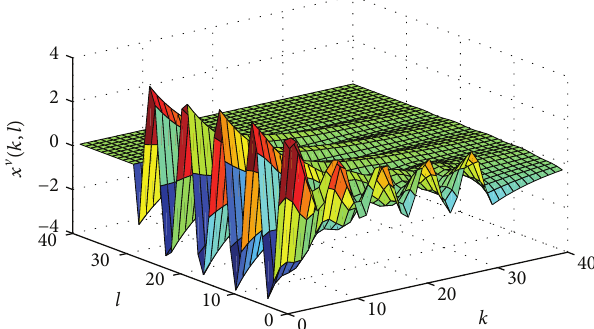
Figure 2: The state trajectory of 𝑥 V (𝑘, 𝑙) with 𝑎 2 = −0.6 .